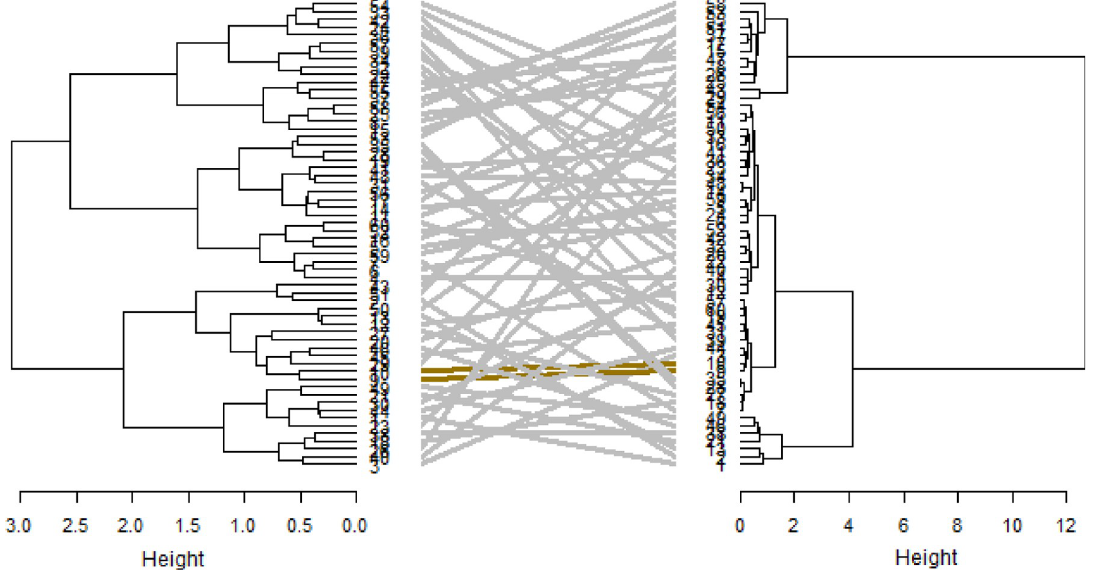
Fig 8. Tanglegram comparison of phenotypic and genotypic dendrograms.